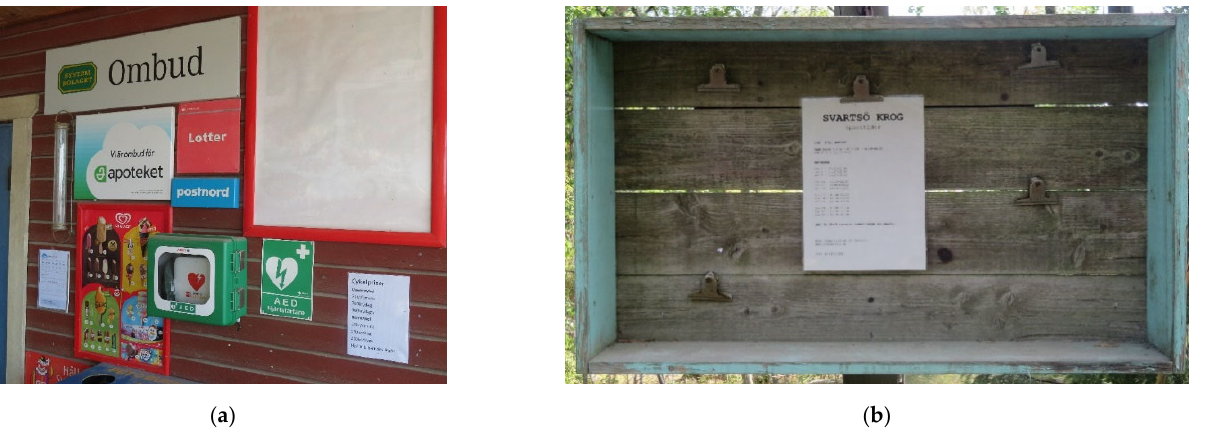
Figure 2. Signs by local businesses: ( a ) Some of the signs outside the shop on Svartsö; ( b ) notice about the opening hours of the restaurant Svartsö krog.